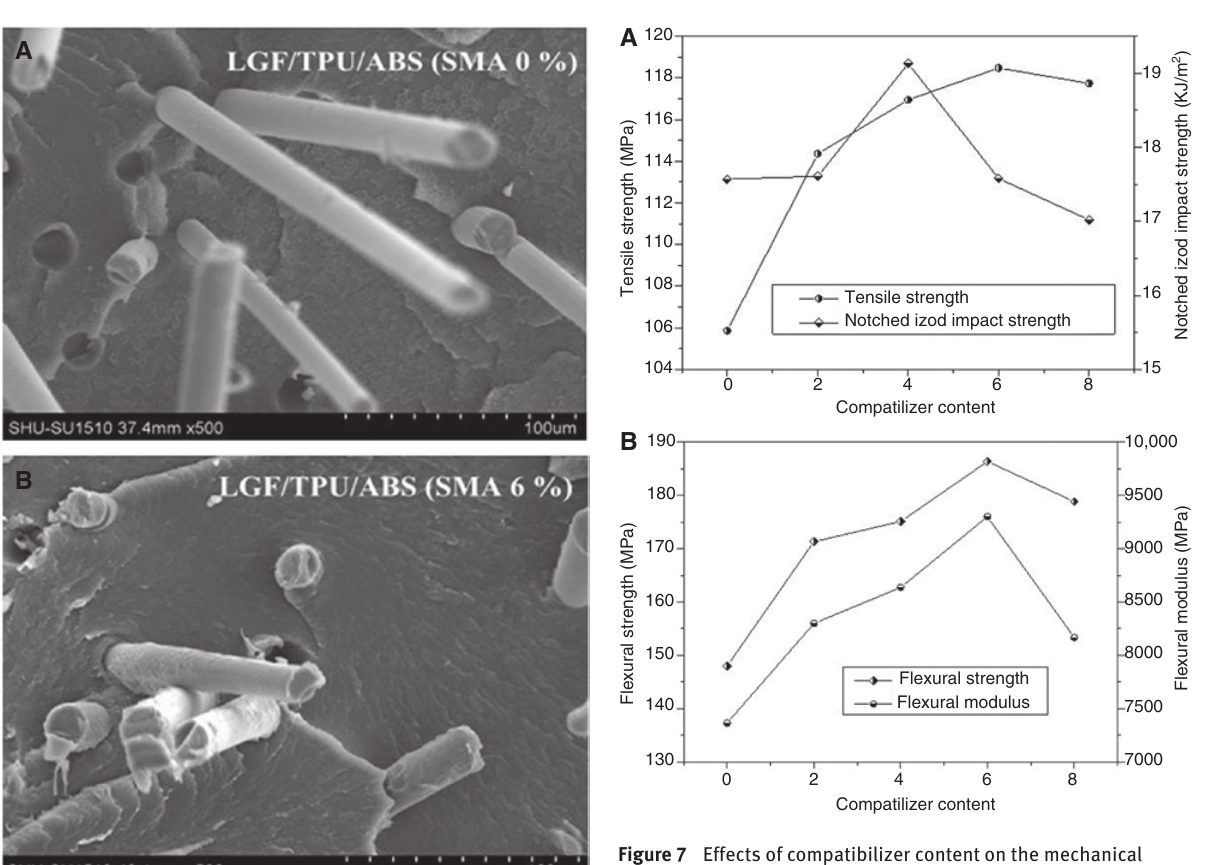
Figure 7 Effects of compatibilizer content on the mechanical properties of the